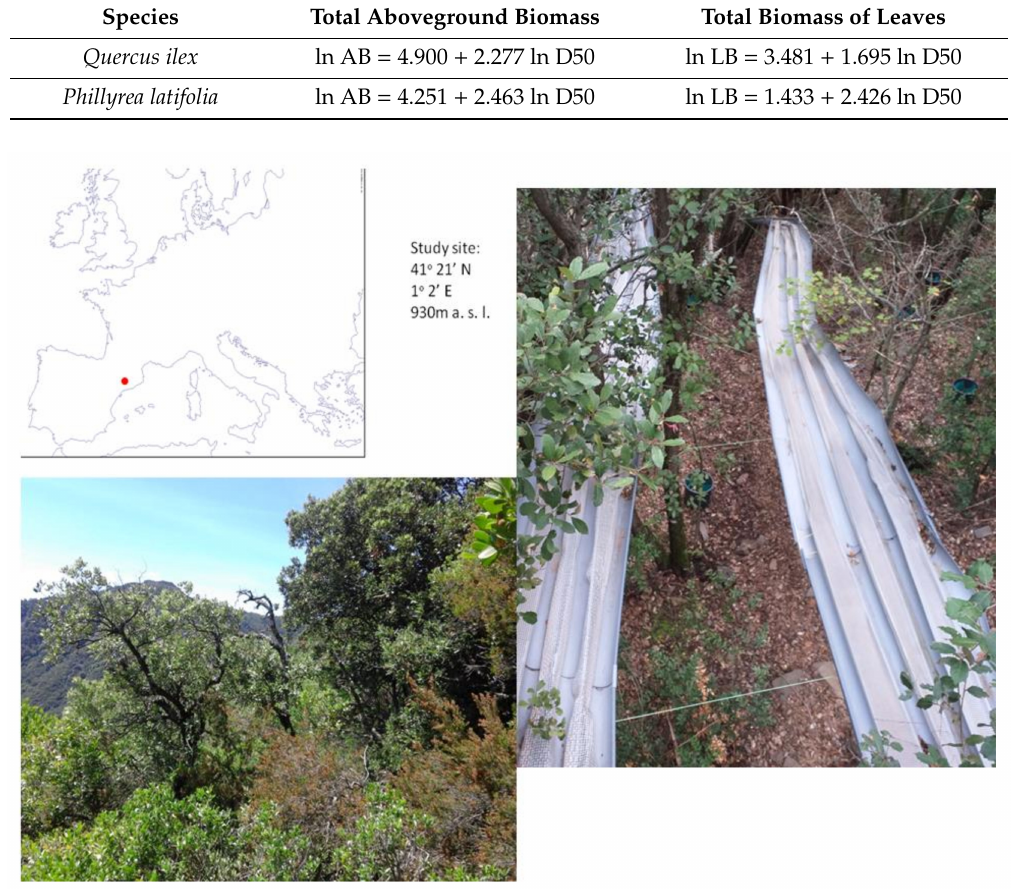
Figure A1. View of the study site and its localization, and view of the partial rainfall exclusion treatment installation and litter collectors. The PVC strips were only placed in plots subjected to partial rainfall exclusion, whereas litter collector baskets were placed in all